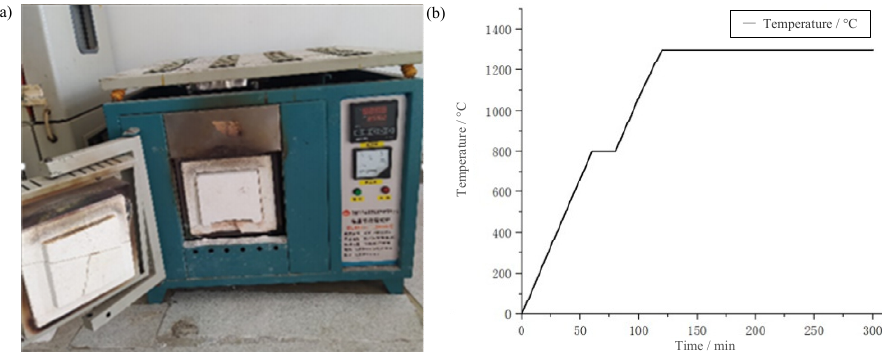
Figure 6. High temperature sintering of thermocouples by means of a muffle furnace: ( a ) Muffle furnace used in the experiment; ( b ) The temperature variation of Muffle furnace in the preparation.